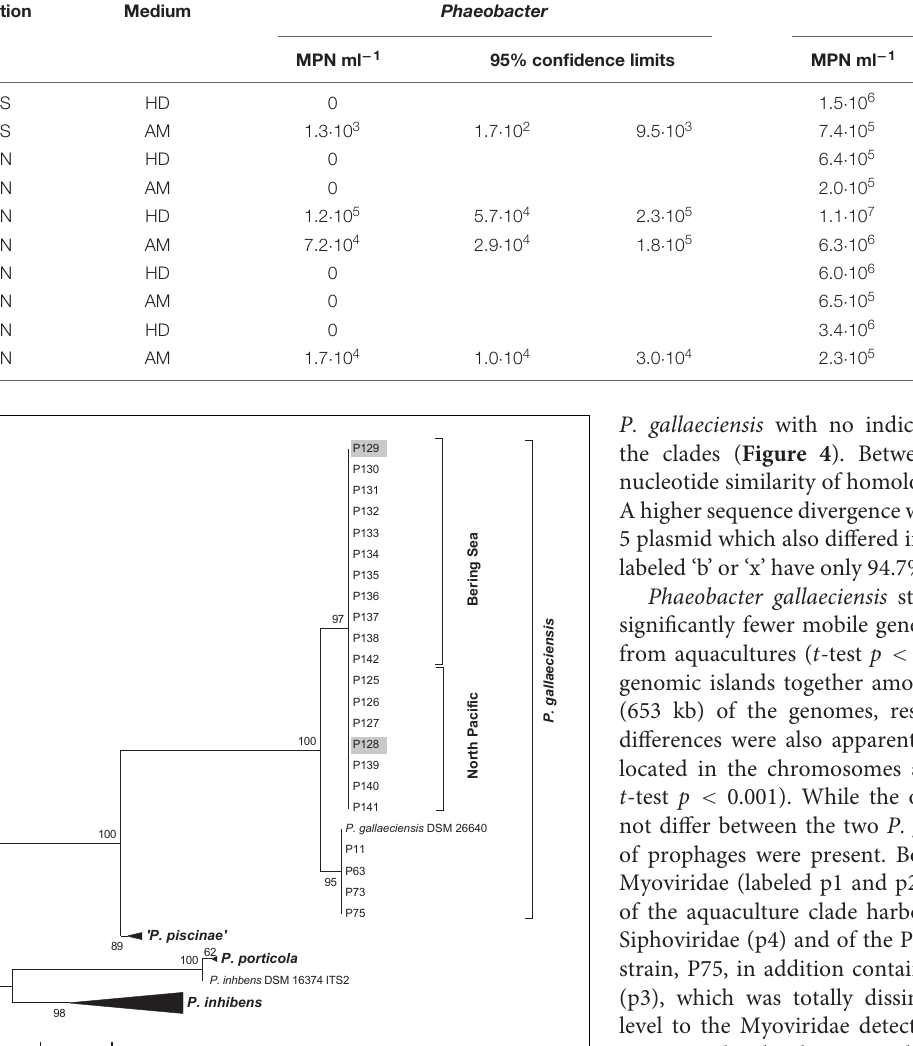
TABLE 2 | Most probable numbers (MPNs) of Phaeobacter per ml plankton biovolume. Station